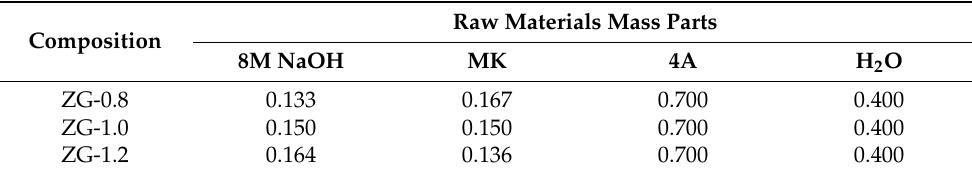
Table 3. Composition of the studied alkali-activated zeolite